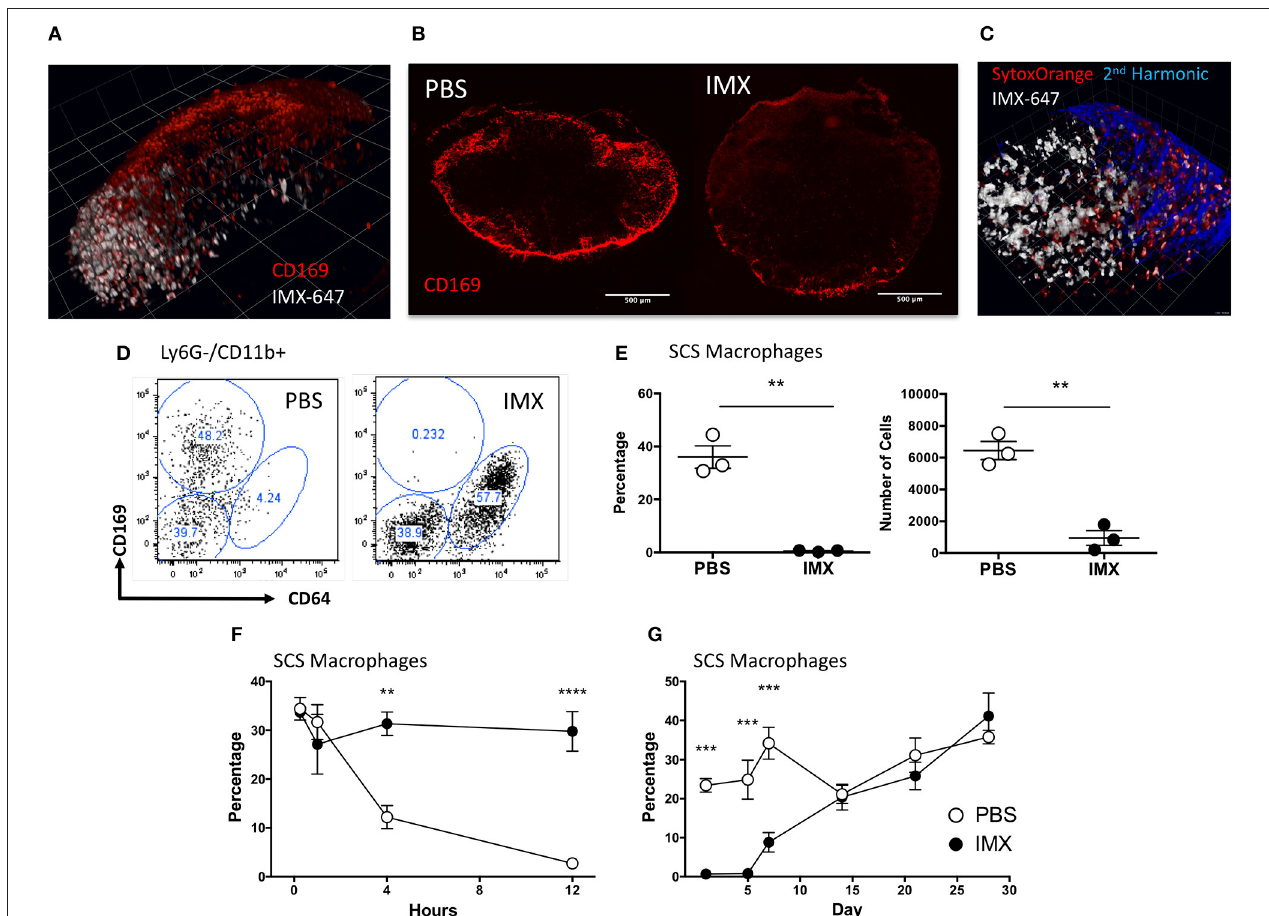
FIGURE 4 | ISCOMATRIX localizes to the subcapsular sinus macrophages and these cells are lost from the lymph node following ISCOMATRIX treatment. (A) Mulitphoton image showing a popliteal lymph node labeled in vivo with a PE conjugated anti CD169 antibody and subsequently treated with 1 IU ISCOMATRIX-647 in the footpad. Imaging was performed 1h after treatment with the ISCOMATRIX-647. (B) CD169 Immunohistochemical staining of cervical lymph nodes 24h following immunization in the ear pinnae with either PBS or ISCOMATRIX. (C) Mulitphoton image showing the popliteal lymph node approximately 2h following the co-administration of the cell impermeable DNA dye Sytox orange and ISCOMATRIX-647 in the footpad. (D) Representative plots showing CD169 and CD64 expression on Ly6G- CD11b + cells in the draining lymph node from mice treated with PBS or ISCOMATRIX at 24h. (E) Flow cytometry data showing the percentage and number of CD11b + cells that are CD169 + SCS macrophages in the cervical lymph node at 24h following immunization with PBS or ISCOMATRIX in the ear pinnae. (F) The percentage of CD11b + cells that are CD169 + SCS macrophages in the cervical lymph node over the first 12h following immunization with PBS or ISCOMATRIX in the ear pinnae. (G) The recovery of the of CD11b + cells that are CD169 + SCS macrophages in the cervical lymph node over 28 days following immunization with PBS or ISCOMATRIX in the ear pinnae. Groups contained 3 animals. IMX, ISCOMATRIX TM adjuvant, ** P < 0.01, *** P < 0.001